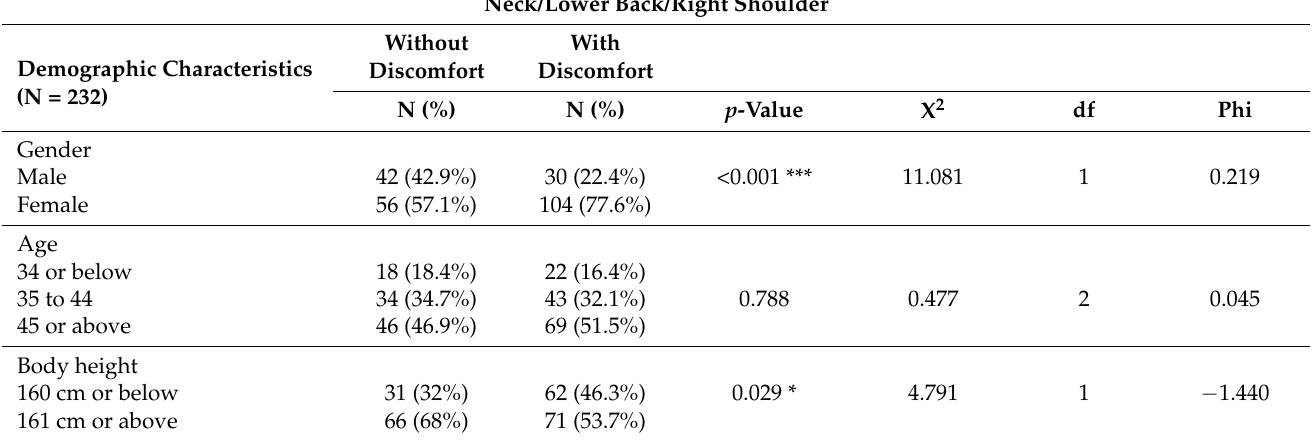
Table A3. The association between demographic characteristics and with/without neck or lower back or right shoulder discomfort.